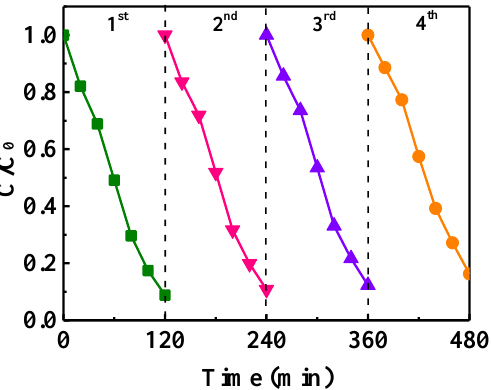
Figure 10. Consecutive runs of the catalytic activity of mesoporous CuO for MO degradation.